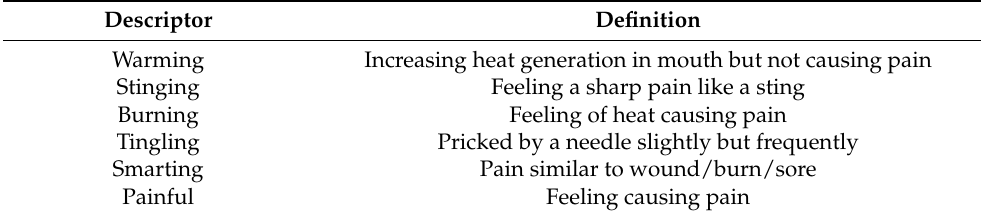
Table 1. Pungency descriptors and